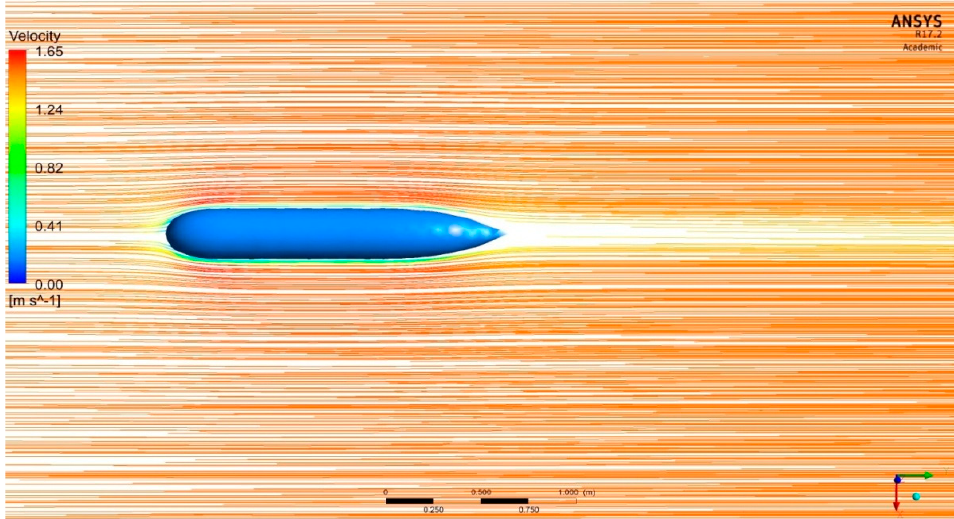
Figure 11. A systematic representation of velocity variations over the fuselage model—Top view.